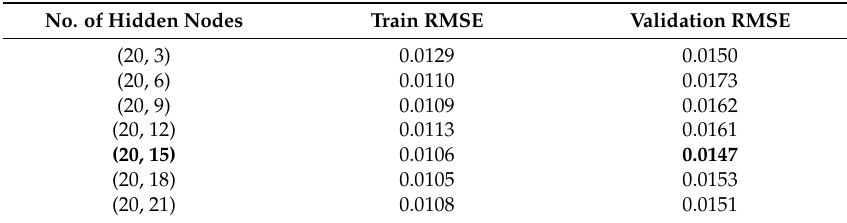
Table 3. Performance comparison of a two hidden layer neural network by varying the number of nodes in the last hidden layer. The first and the second elements of the No. of Hidden Nodes are node numbers of the first and the second hidden layers, respectively.